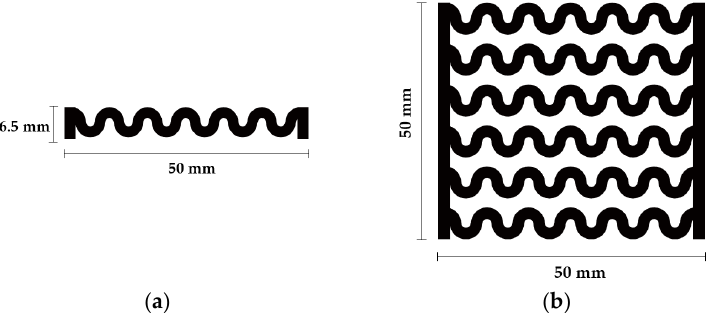
Figure 1. Scheme of designing ( a ) one line and ( b ) six lines of horseshoe pattern.